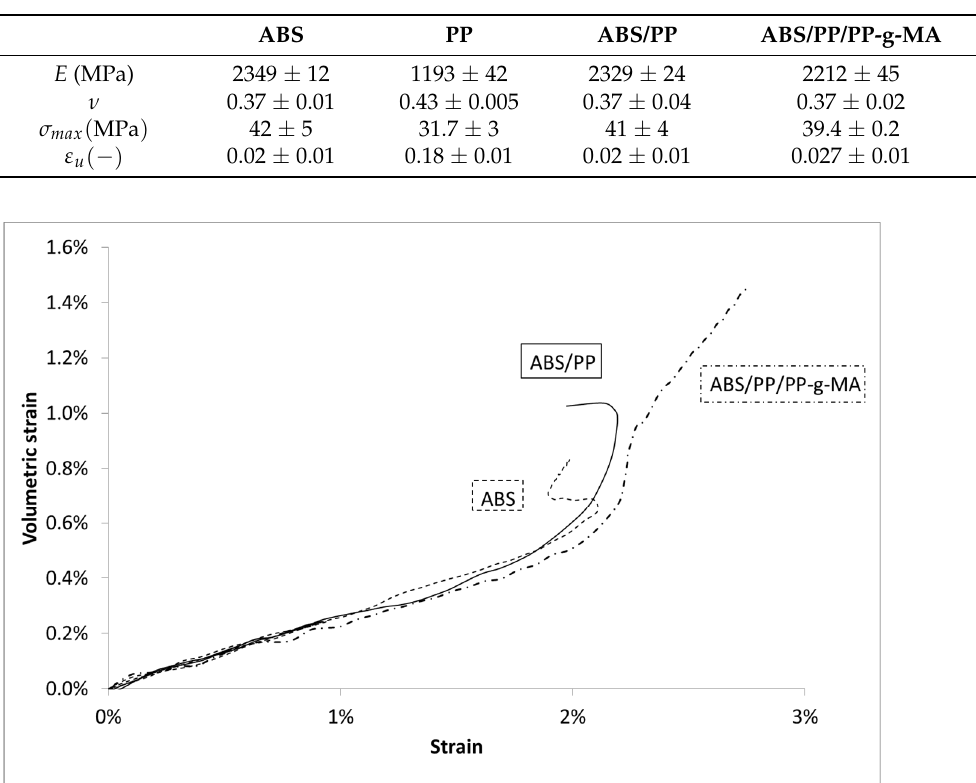
Figure 5. Stress vs. Lagrangian strain in uniaxial tensile tests at 10 mm/min for ABS, PP, and composites. Table 2. Elastic and ultimate properties deduced from experiments for ABS, PP, ABS/PP composites at 10 mm/min.